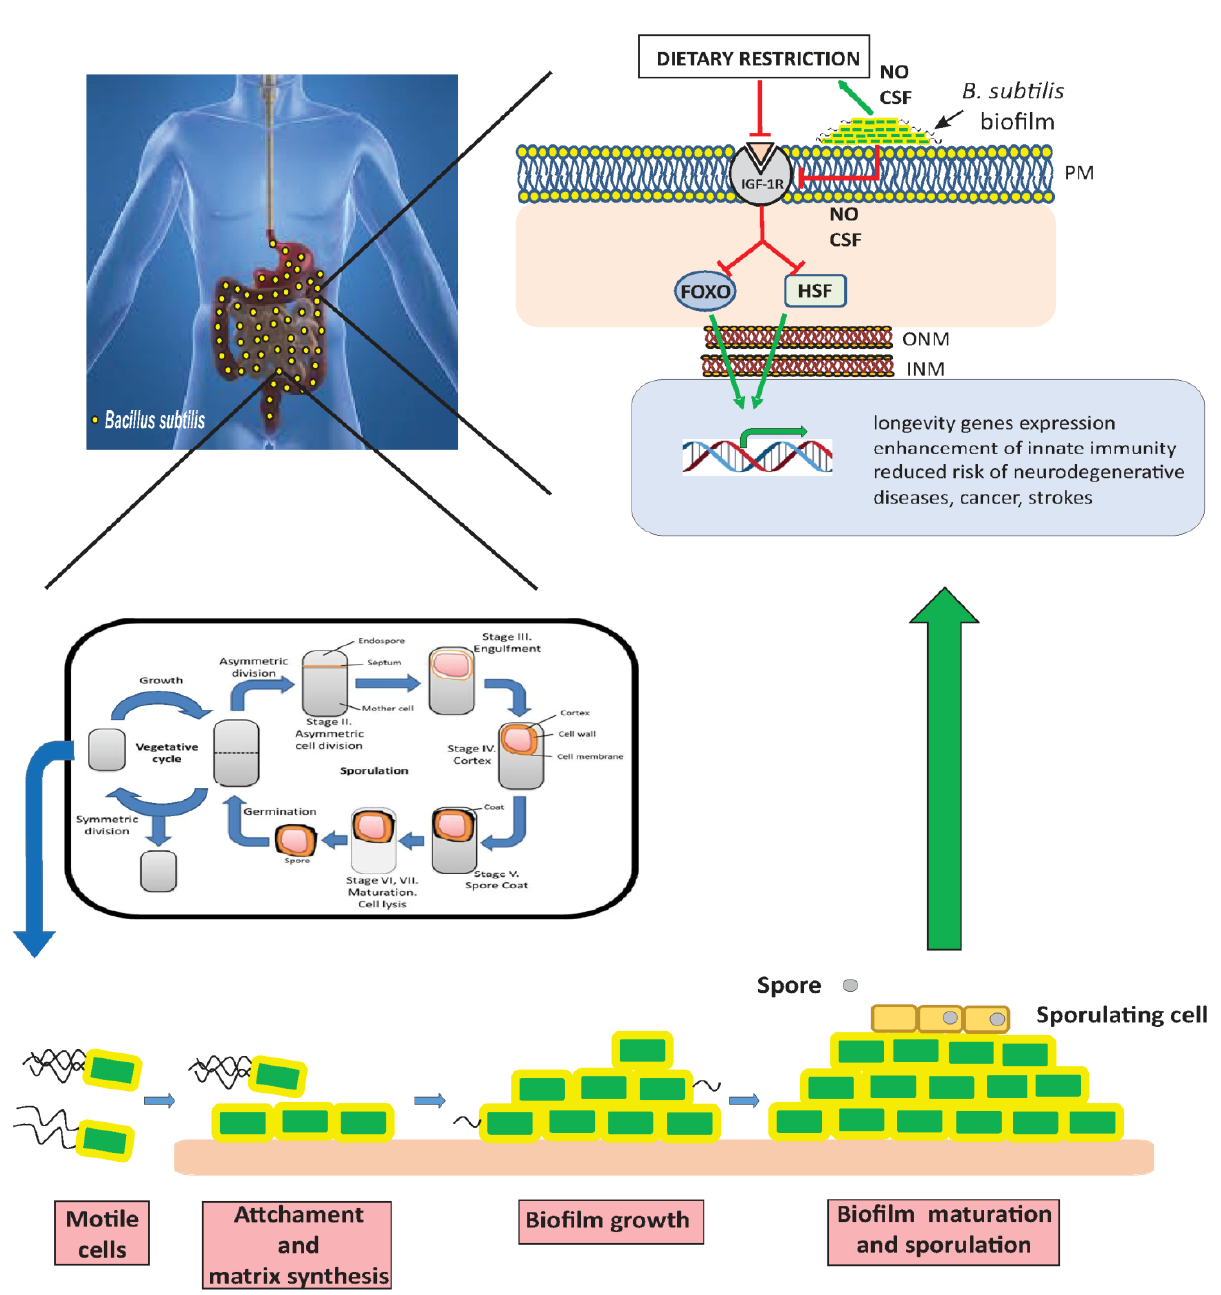
FIGURE 1: A workable model of how probiotic B. subtilis improves host health and longevity. Once spores of the probiotic bacterium B. subtilis are incorporated in the diet and consumed, they survive the transit through the stomach and reach the human intestine (Left car- toon) . These gut spores germinate and the active form of the probiotic (vegetative cells of B. subtilis ) emerges, multiples and forms a bene- ficial biofilm in the host intestine (Bottom cartoon) . Biofilm B. subtilis cells produce a continued and coordinated provision of beneficial and anti-aging NO and CSF molecules to the host tissues (bottom and right cartoons). At genetic level, longevity is regulated by the activity of the gene-transcription factors FOXO and HSF (Right cartoon) . The binding of insulin-like molecules activates insulin receptor which in turn acti- vates a series of protein kinase enzymes that phosphorylate FOXO, keeping it inactive in the cytoplasm. Additionally, active insulin receptor is responsible for the formation of an inhibitory protein complex that sequesters HSF in the cytoplasm. Beneficial signals (NO, CSF and oth- ers) derived from the biofilm established by B. subtilis produce a direct or indirect (through DR activation) downregulation of insulin recep- tor (Right cartoon) . Upon downregulation of the insulin receptor, FOXO and HSF become active in the nucleus. There, both prolongevity transcription factors orchestrate the activation of host genes responsible for (i) resistance to age-related diseases and (ii) a prolonged and healthy longevity. Symbols: ( ^ ) repression, (↓)